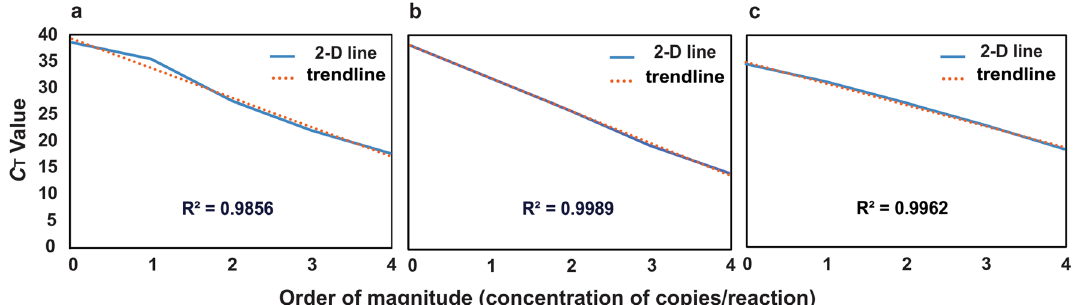
Figure 2. Standard curves of three qPCRs (Target: ( a ) Escherichia coli , ( b ) Saccharomyces cerevisiae , and ( c ) Human cytomegalovirus; Primer: ( a ) specific primers of Escherichia coli , ( b ) ITS3/4 fungal primers, and ( c ) specific primers of Human cytomegalovirus) display negative linear relationships between the initiated copies of each pathogen and the corresponding C T values. R 2 values indicate the sufficient quality of primers to yield the reliable experimental